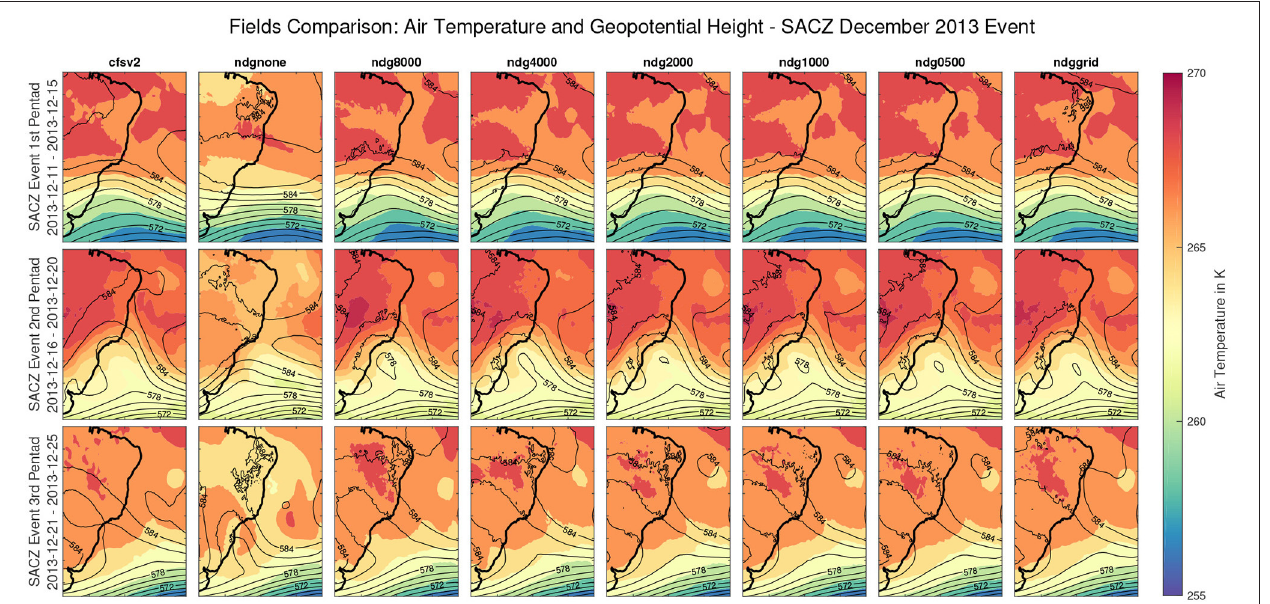
FIGURE 3 | Temperature (filled contours, in K) and geopotential height (black contours, in m) at 500 hPa. Top, middle, and bottom rows show averages calculated for the first, second and third pentads of the SACZ event, respectively.